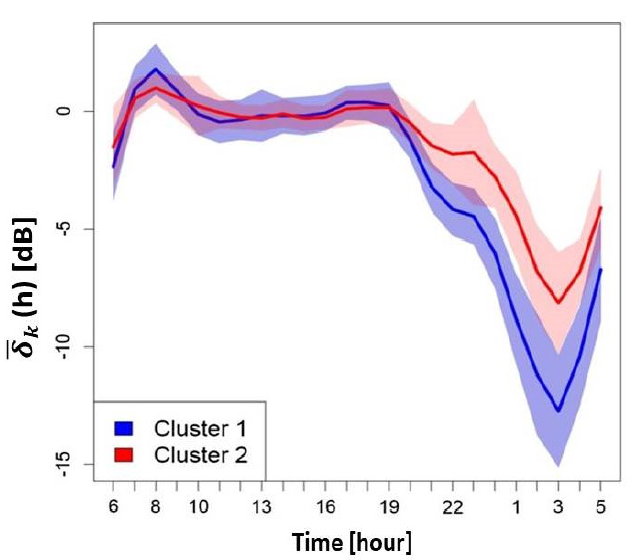
Figure 3. Mean normalized hourly cluster profiles, δ k ( h ) [dB], vs. day hour h , for the two clusters of index k = 1,2, obtained from the 93 preliminary measurements over the whole city of Milan (see e.g., [68]). The standard deviations of the profiles are indicated by the colored bands. (With permission from